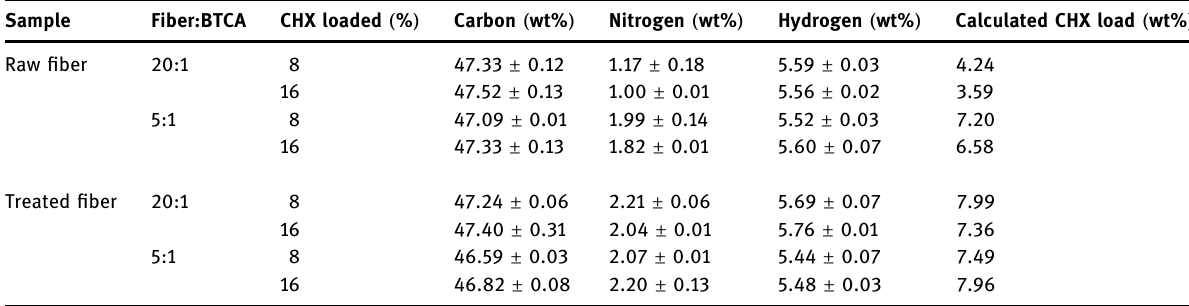
Table 3: Elemental analysis of cross - linked fi bers by CHNSO - analyzer and loading e ffi ciency of CHX